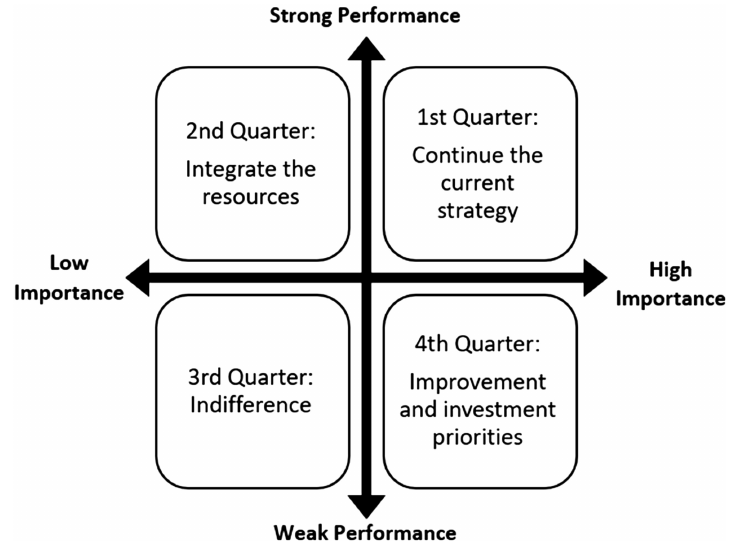
Figure 2. The importance – performance matrix and the corresponded